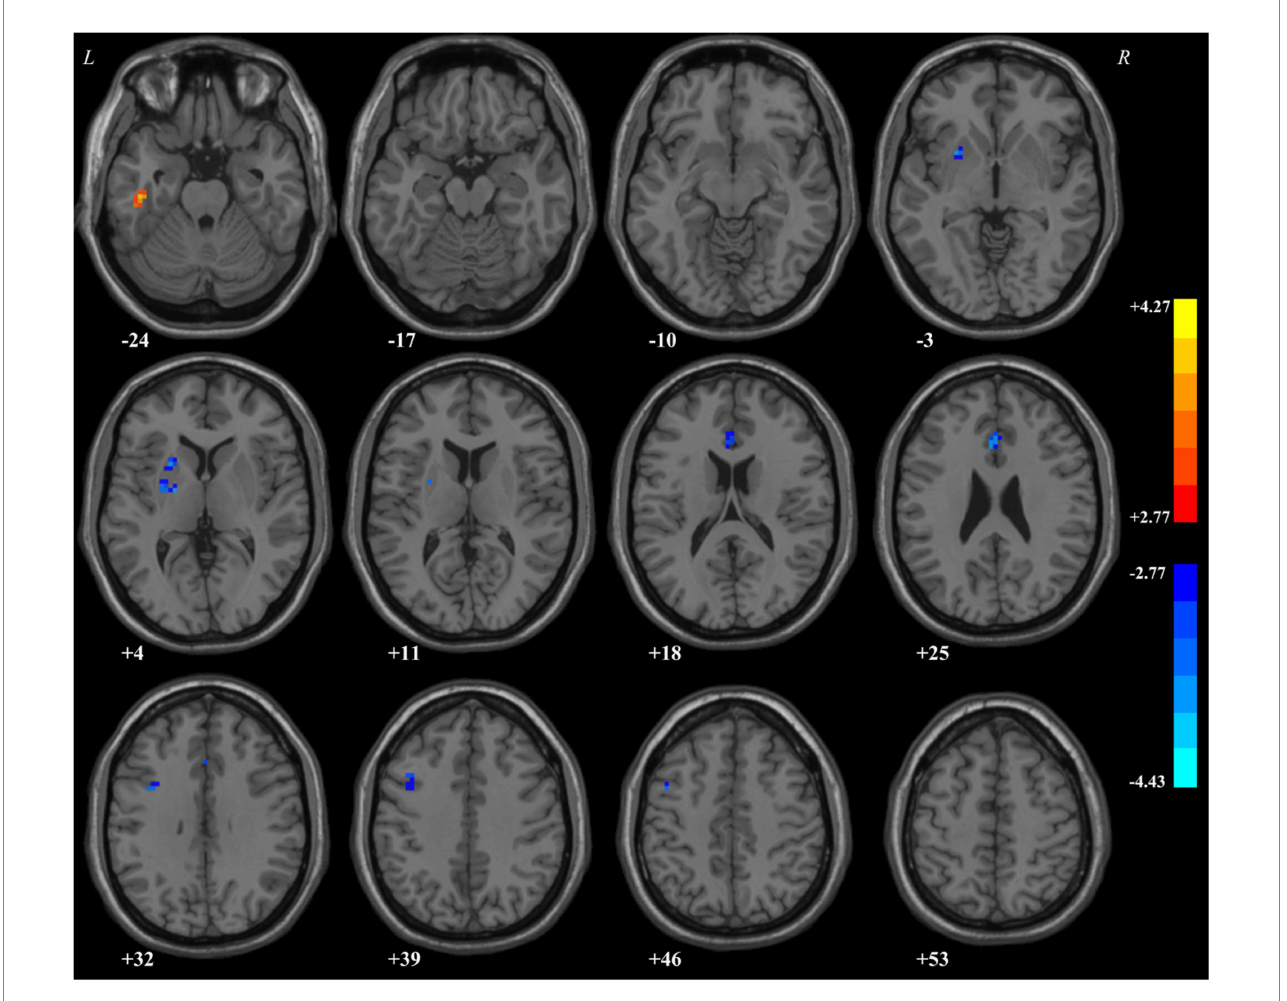
FIGURE 1 Regions with abnormal regional homogeneity values in the